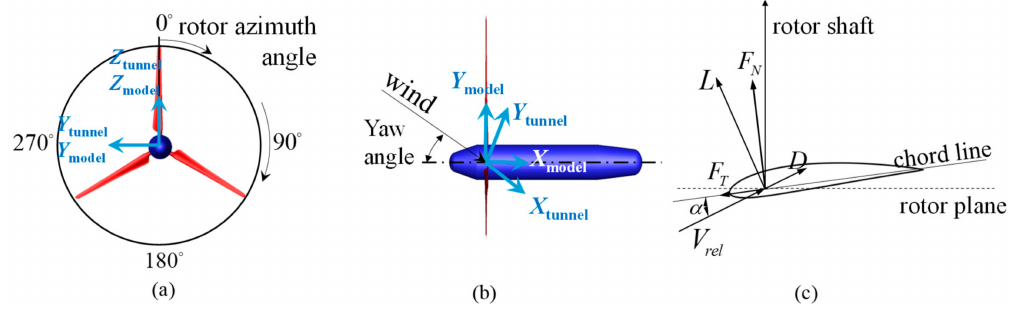
Figure 2. ( a , b ) Descriptions of the wind tunnel and rotor coordinate systems for yaw computations and ( c ) forces on a blade cross-sectional element.